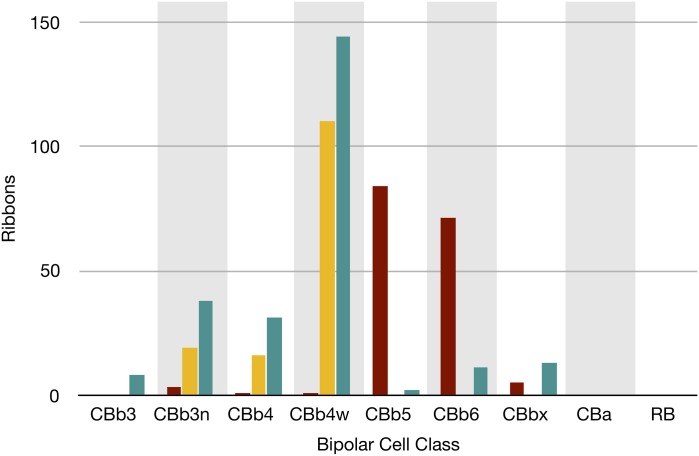
The classes of bipolar cell input to GC 606 (Cyan, n = 247), IAC 9769 (gold, n = 145) and all ON starburst amacrine cell (SAC) dendrites (red, n = 165) in RC1. Ordinate: number of synaptic ribbons from each class. Abscissa. All bipolar cell groups, including ON cone bipolar cell classes CBb3, CBb3n, CBb4, CBb4w, CBb5, CBb6, the aggregate OFF cone bipolar cell superclass (CBa) and the rod BC class. CBbx cells are ON cone bipolar cells from the volume margins with insufficient reconstruction to allow identification.